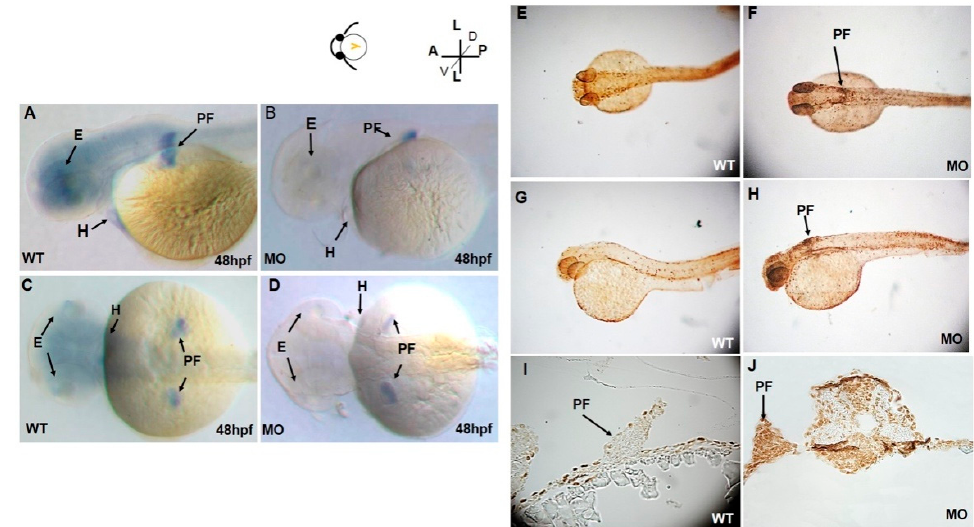
Figure 2. Lateral ( A ) and dorsal ( C ) views of tbx5a gene expression in the eyes, heart, and bilateral pectoral fins of wild-type embryos at 48 hpf. tbx5a gene expression in the eyes, heart, and pectoral fins was severely inhibited at 48 hpf in both the lateral ( B ) and ventral ( D ) views. Detection of apoptotic cells by the TUNEL assay in wild-type ( E , G , I ) and tbx5a knockdown ( F , H , J ) zebrafish embryos at 37 hpf. No TUNEL-positive cells are observable in the dorsal view ( E ), lateral view ( G ), or cross sections at the pectoral fin level ( I ) in wild-type embryos. However, massive numbers of TUNEL-positive cells in the pectoral fin region (black arrow) in the tbx5a morphant embryos were visible in the dorsal view ( F ), lateral view ( H ) and cross section at the pectoral fin level ( J ). WT, Uninjected group; MO, tbx5a morphant group; PF, pectoral fin; E, eye, H, heart.